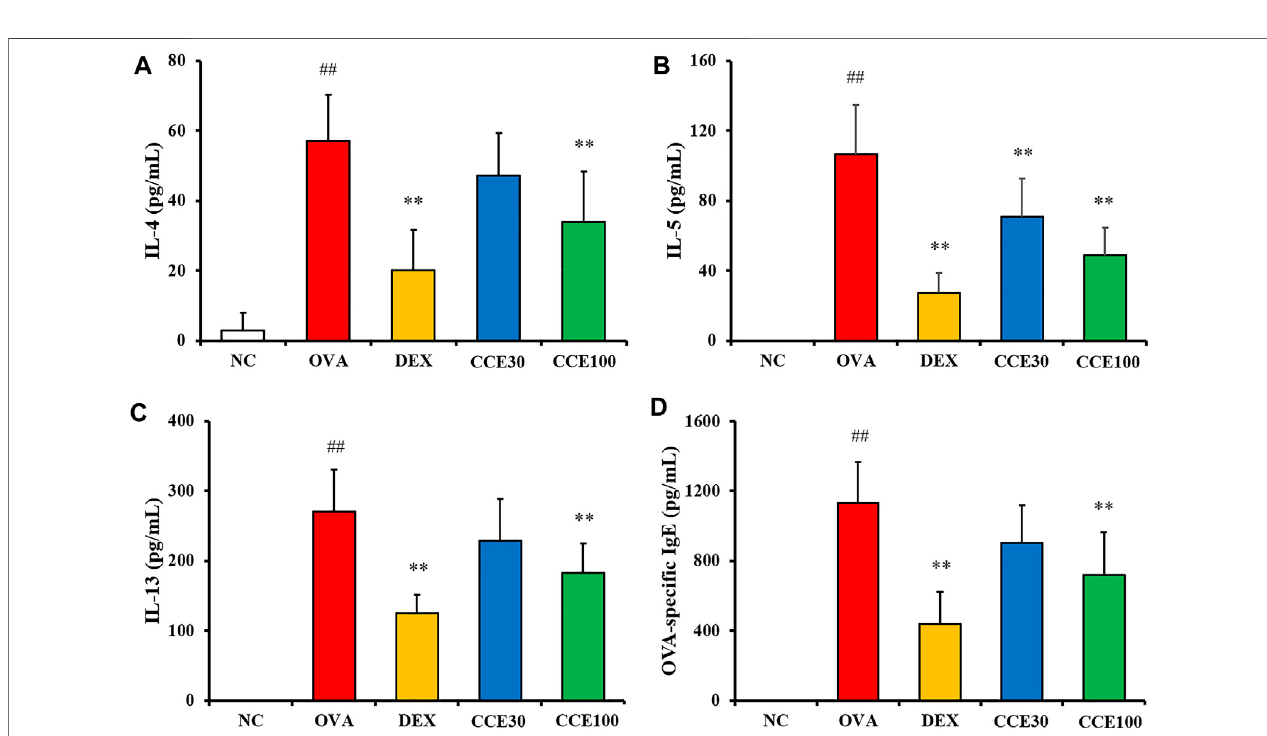
FIGURE 4 | CCE declined the production of in fl ammatory cytokines in BALF and OVA-speci fi c IgE in serum in OVA-exposed mice. (A) IL-4, (B) IL-5, (C) IL-13, (D) OVA-speci fi c IgE. NC, nonasthma and PBS treatment; OVA, asthma and PBS treatment; DEX, asthma and dexamethasone treatment; CCE 30 and CCE 100, asthma and CCE treatment (30 and 100 mg/kg, respectively). ## p < 0.01, vs . NC; ** p < 0.01 vs. OVA ( n = 7 per group).